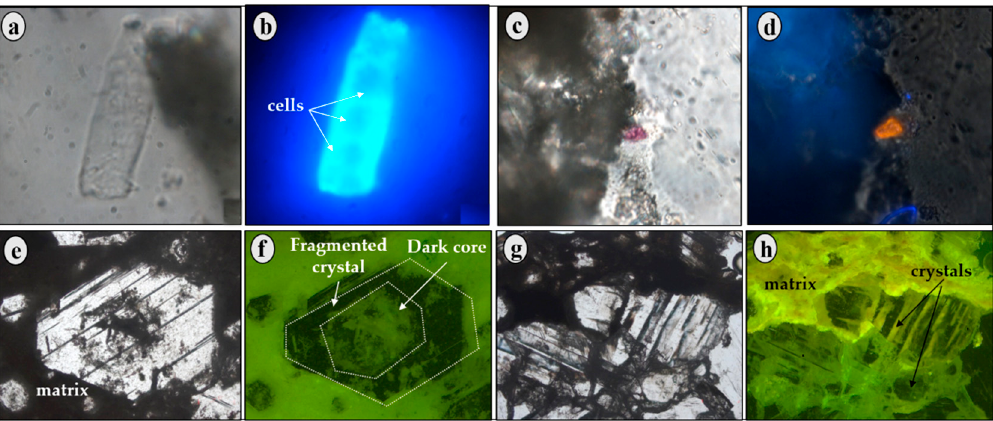
Figure 5. Allochthonous and autochthonous materials. ( a ) segmented debris (60 μ m in size) composed of five cells and emitting blue fluorescence ( b ); ( c ) irregular red material (<10 μ m in size) displaying red fluorescence ( d ); ( e ) hexagonal and fragmented crystal showing epifluorescent brown materials that follow the crystal’s morphology ( f ); ( g ) contact between crystals and matrix which shows a bright fluorescence ( h ).